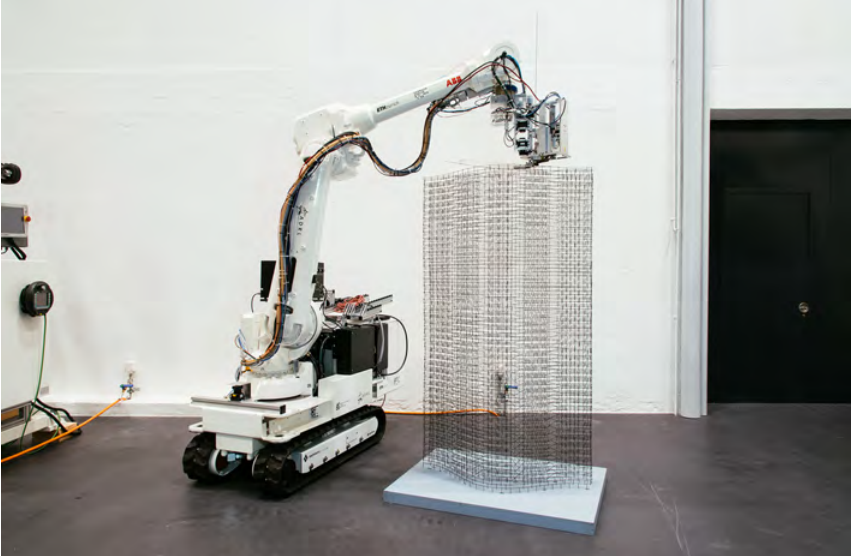
Figure 5. An example of a robot